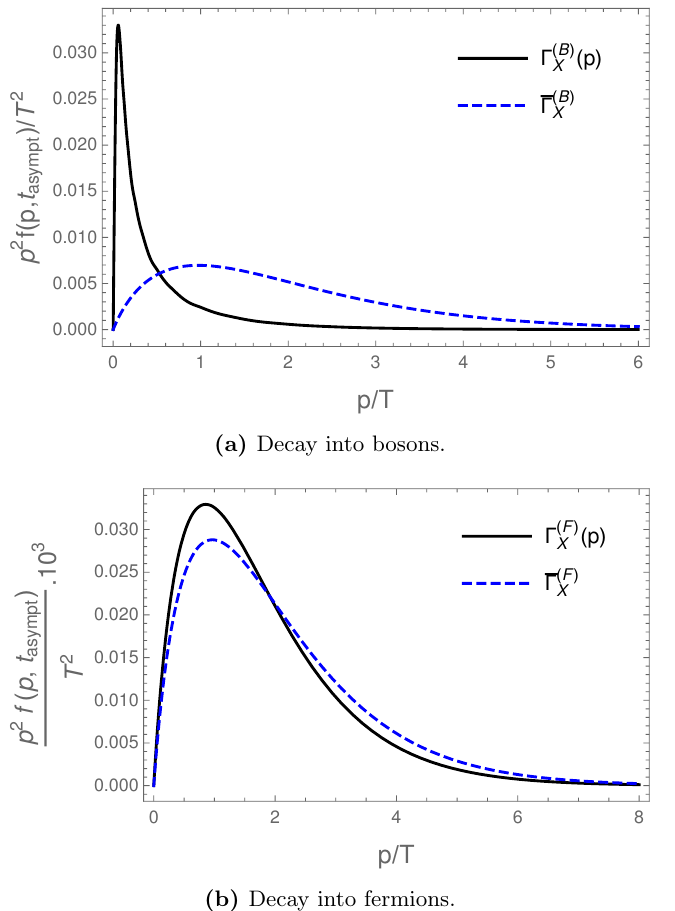
Figure 2. The phase space distribution, as a function of the momentum p , at large asymptotic times (when the distributions have already reached the stationary state), for decay into bosons (a) and for decay into fermions (b). The parameters used are m X = 0 : 001 T and (cid:0) ( B;F ) =H = 0 : 5, which 0 corresponds to (cid:13) ( B ) = 0 : 0245 (bosons) and (cid:13) ( F ) = 10 (cid:0) 4 (fermions). Solid lines yield the solution X X when considering the full momentum dependent decay widths, while dashed lines correspond to the solution obtained using the constant thermally averaged decay